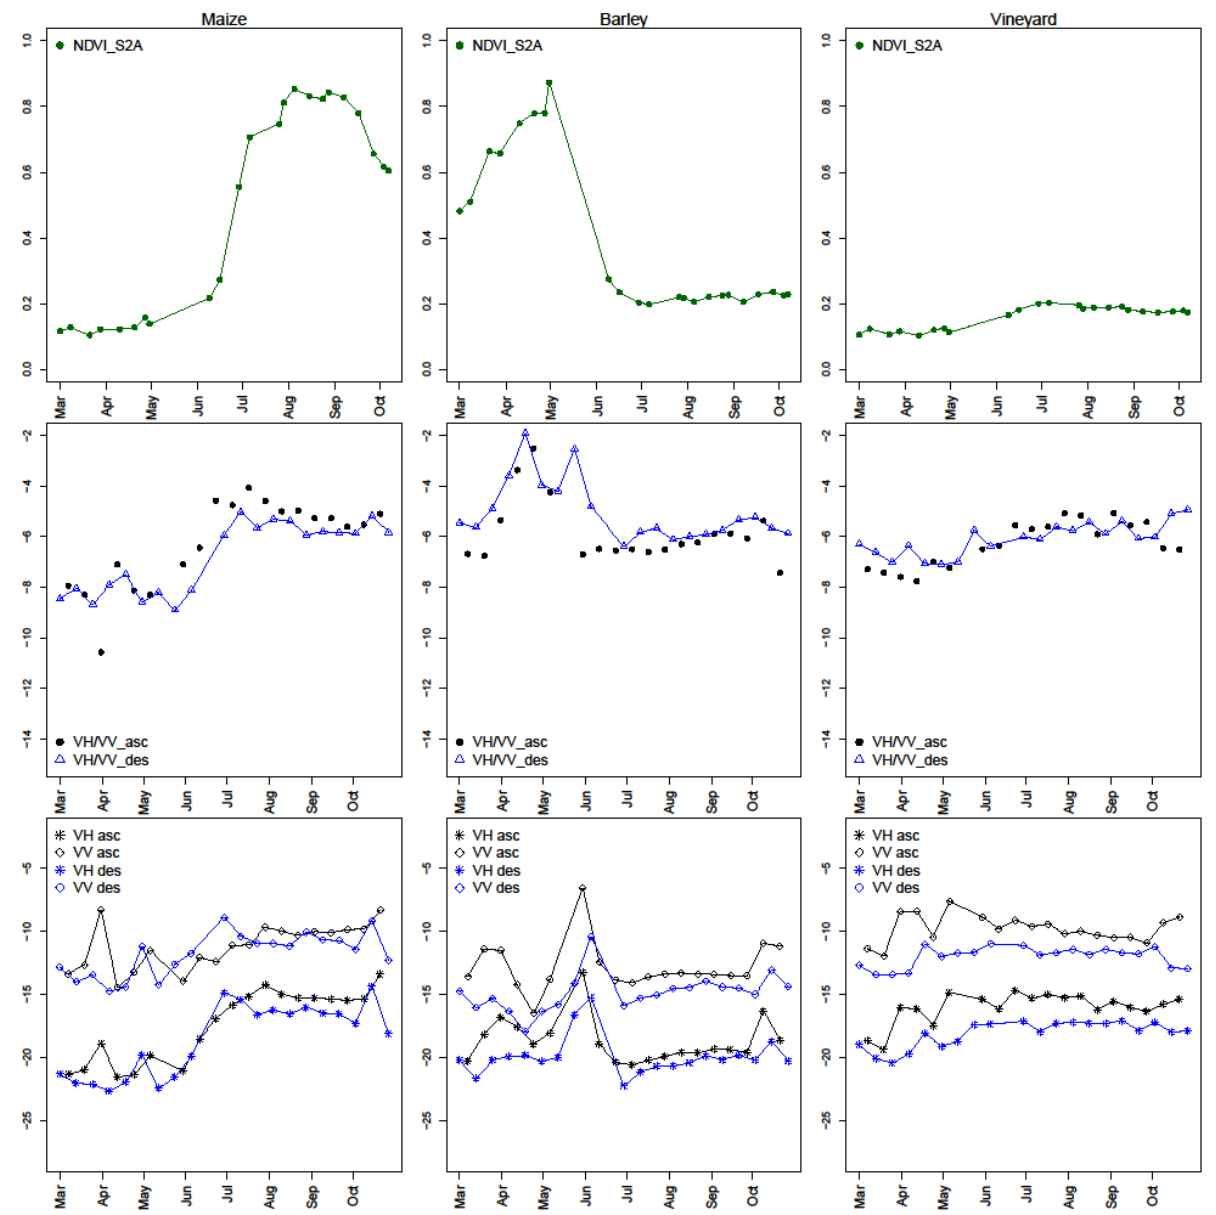
Figure 5. Temporal signatures of maize, barley, and grapevines for Normalized Difference Vegetation Index (NDVI), cross ratio (CR), VH, and VV. Two relative descendant (des) and ascendant (asc) orbits are represented in blue and black, respectively.